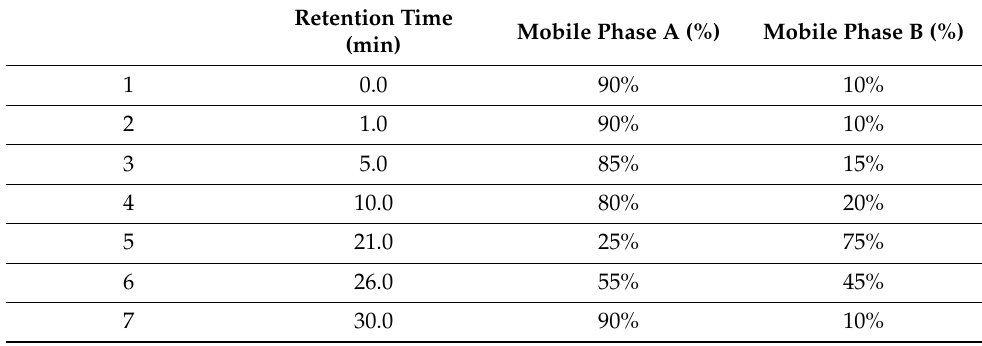
Table 2. Phenolic content analysis: gradient shape used during HPLC/DAD analysis. Retention